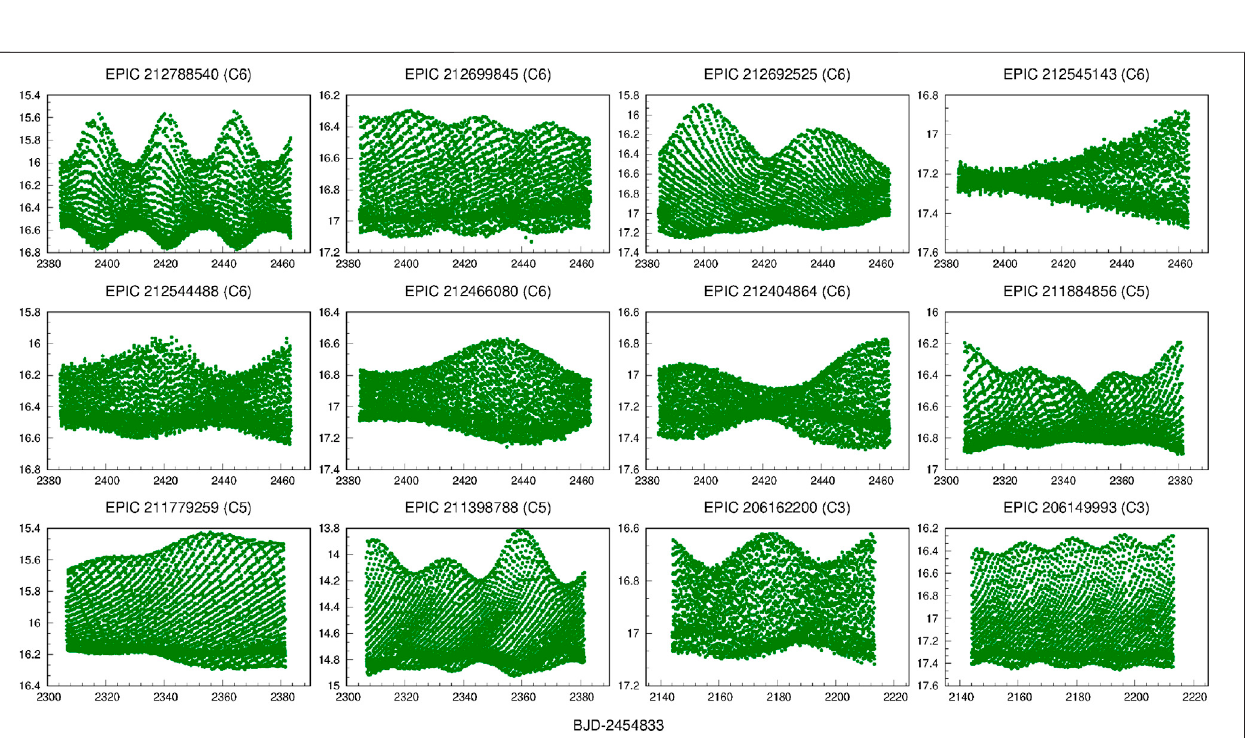
FIGURE 9 | Blazhko stars in the K2 mission. Based on the light curves published by Plachy et al. (2019).